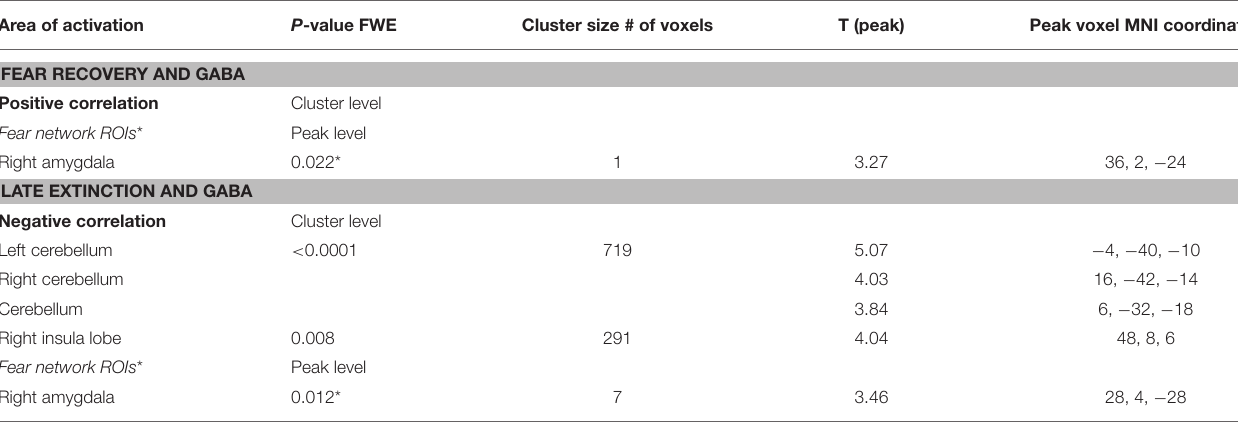
TABLE 3 | GABA and BOLD responses. Voxel-wise correlations of dACC GABA and BOLD